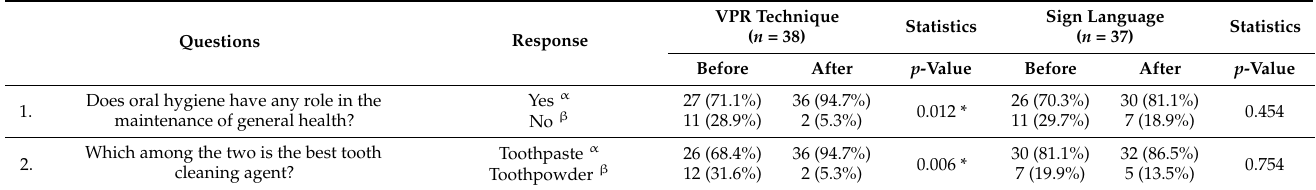
Table 1. Comparison of oral hygiene knowledge in the study population before and after the VPR technique and sign language technique